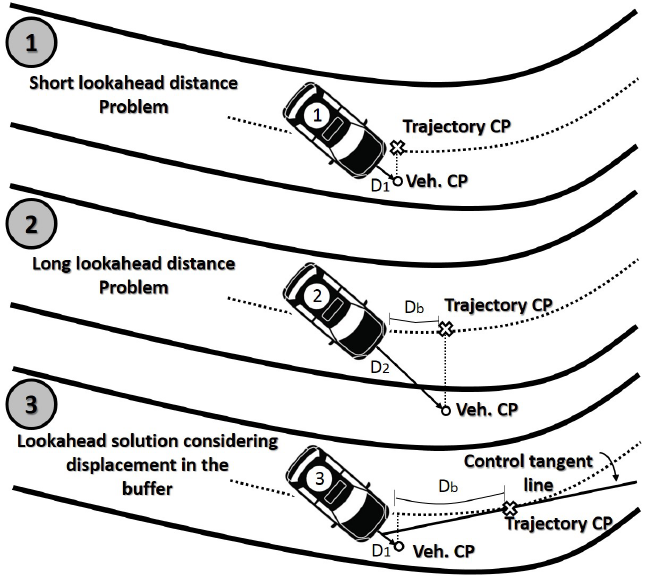
Figure 6. Lookahead distance: state of the problem.